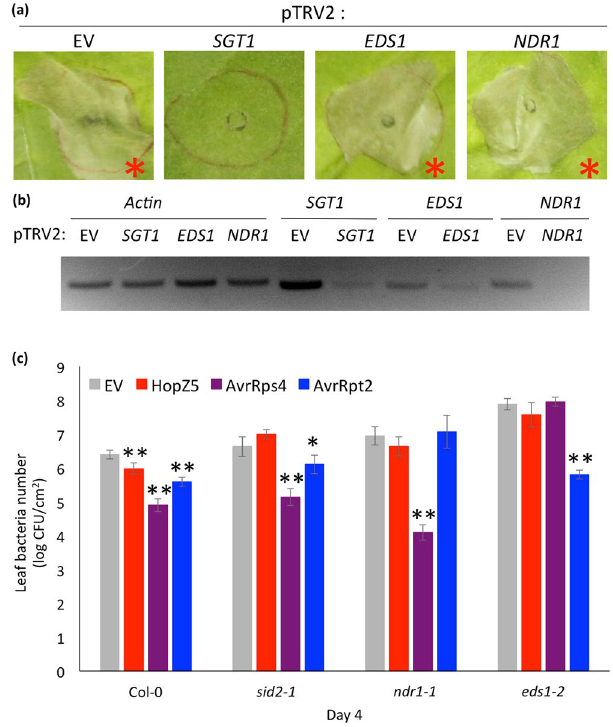
Figure 2. HopZ5 recognition occurs in Nicotiana benthamiana and requires SGT1 but not NDR1 or EDS1 . ( a ) SGT1 -silenced N. benthamiana loses HopZ5-triggered hypersensitive response. Two-week-old N . benthamiana seedlings were infiltrated with Agrobacterium tumefaciens AGL1 carrying pTRV2 targeting SGT1 , EDS1 or NDR1 for silencing, or the empty pTRV2 vector alone. 4–5 weeks post VIGS treatment, YFP-tagged variants of HopZ5 was transiently expressed and photographs taken at 3 days post infiltration. Red asterisks indicate development of cell death symptoms. The experiment was conducted three times with similar results. ( b ) Silencing of target genes was confirmed by RNA extraction from multiple leaves followed by semi-quantitative polymerase chain reaction. Actin was used as control for RNA. Labels above indicate the gene tested for expression by semi-qPCR while labels below indicate the silencing construct used. ( c ) Pto DC3000 carrying EV, hopZ5 - HA , avRps4 or avrRpt2 was blunt syringe-infiltrated at 5 × 10 5 CFU/mL into leaves of Arabidopsis wildtype Col-0, sid2-1 , ndr1-1 , or eds1-2 mutant lines. Bacterial growth was determined 4 days post-infection (4 dpi). Error bars represent standard error from six technical replicates. Asterisks indicate results of Student’s t -test between selected sample and EV for that accession; * ( P < 0.05), ** ( P < 0.01). The experiment was conducted three times with similar